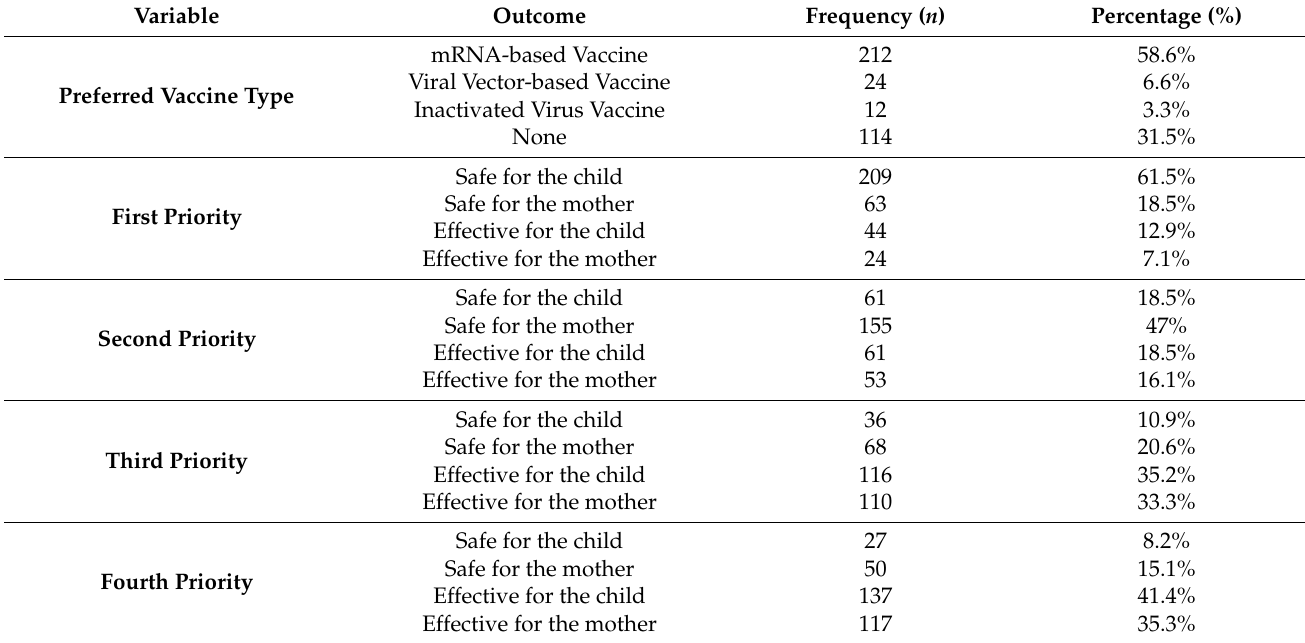
Table 5. Preferred vaccine type and top priorities of pregnant and lactating women (PLW), University Hospital Brno, August–October 2021 ( n = 362).